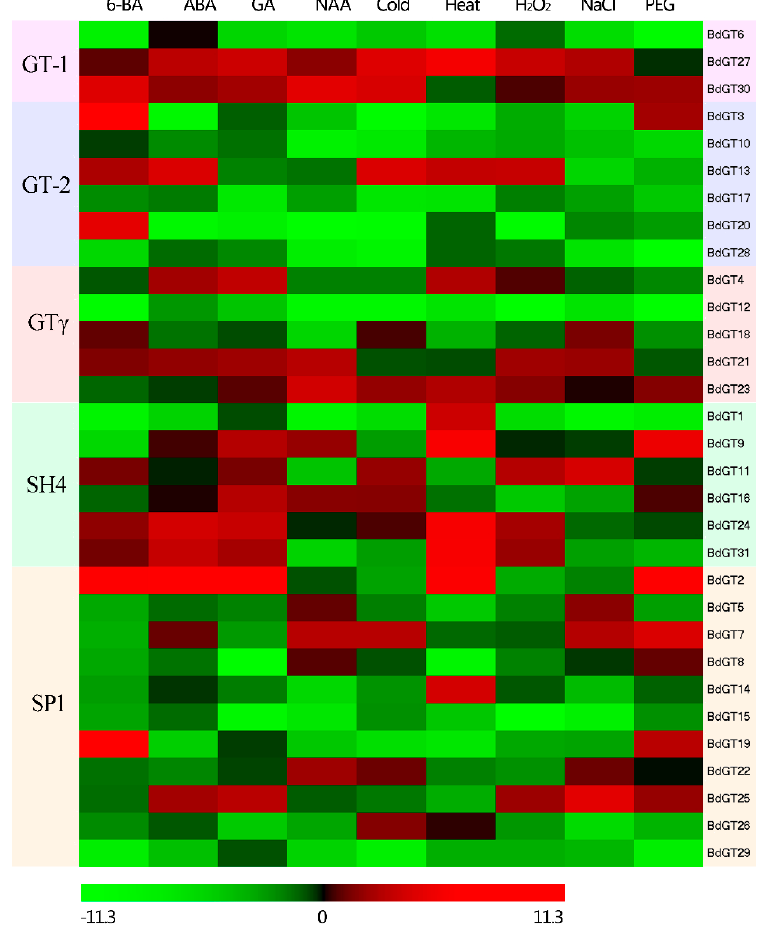
Figure 7. Expression patterns of GT genes in B. distachyon in response to phytohormone and abiotic stresses. Levels of up-expression (red) or down-expression (green) are shown on a log2 scale from the highest to the lowest expression of each BdGT